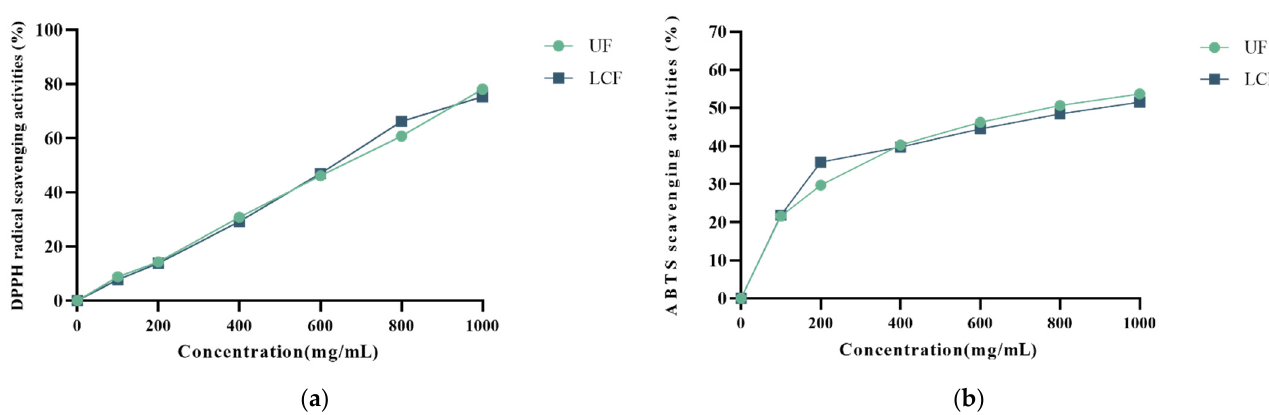
Figure 4. Phenolic components from samples of Euryale ferox show DPPH ( a ) and ABTS ( b ) scavenging properties. UF: unfermentation; LCF: single microbial fermentation with L. curvatus.